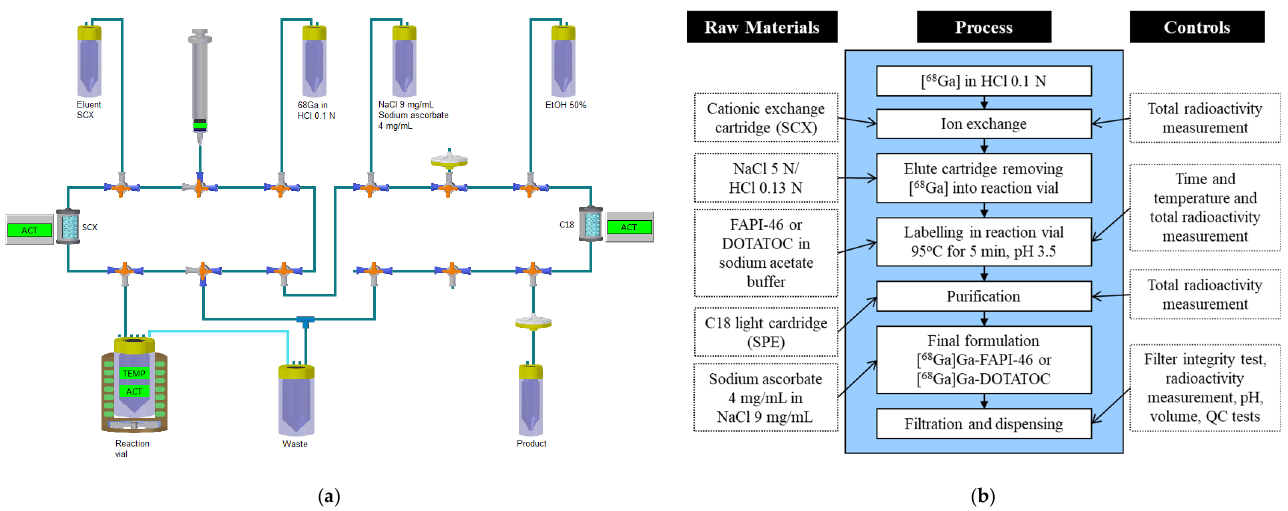
Figure 3. ( a ) Schematic illustration for the synthesis of [ 68 Ga]Ga-FAPI-46 or [ 68 Ga]Ga-DOTATOC using Modular-Lab Pharmtracer (Eckert and Ziegler). ( b ) Flow diagram of the GMP-compliant synthesis of 68 Ga-based radiopharmaceuticals using Modular-Lab Pharmtracer synthesis module.